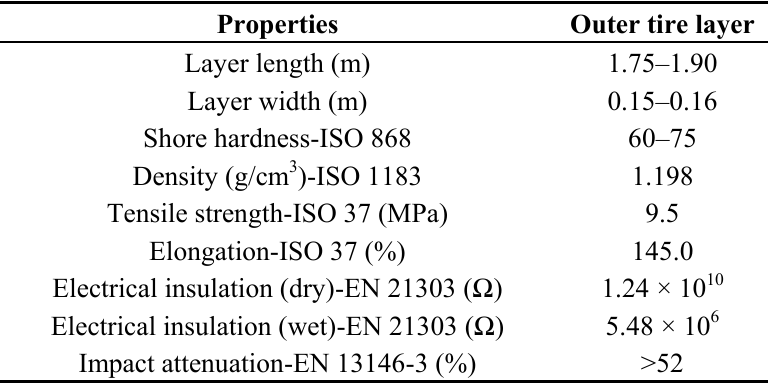
Table 1. Tread layer